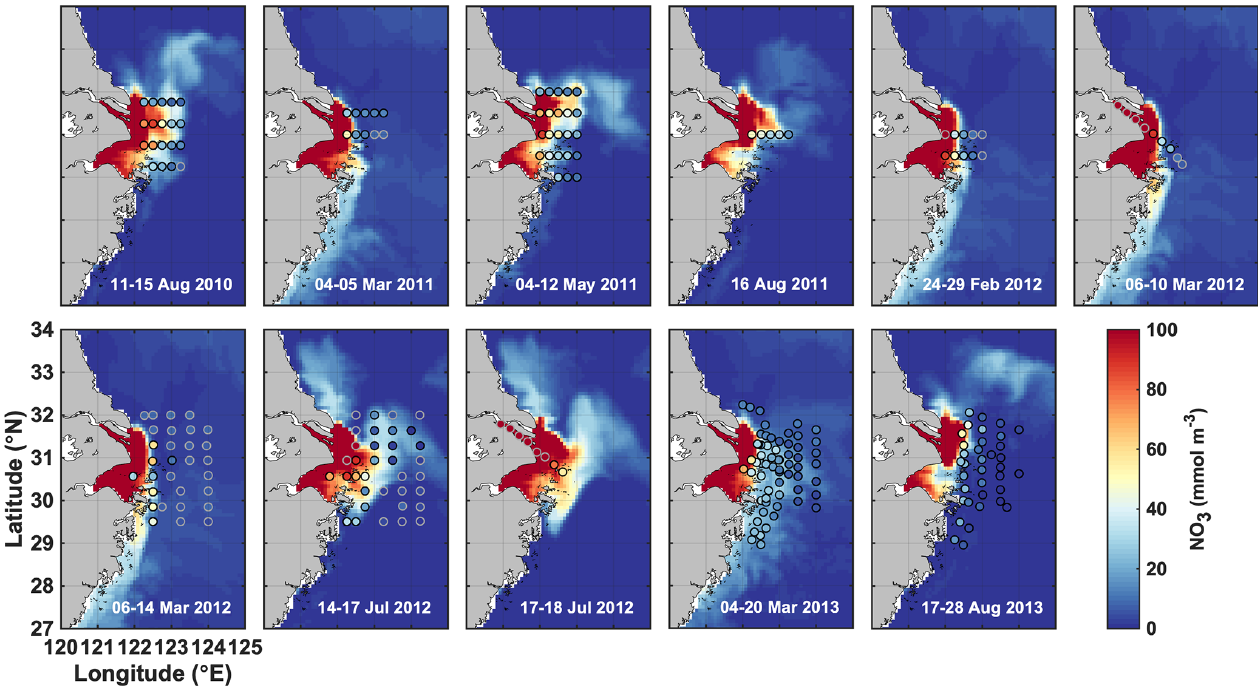
Figure 2. Simulated surface nitrate (colored map) shown for the day that marks the mid-point of the cruise dates (given in each panel) compared to observations (dots) during 11 cruises from 2011 to